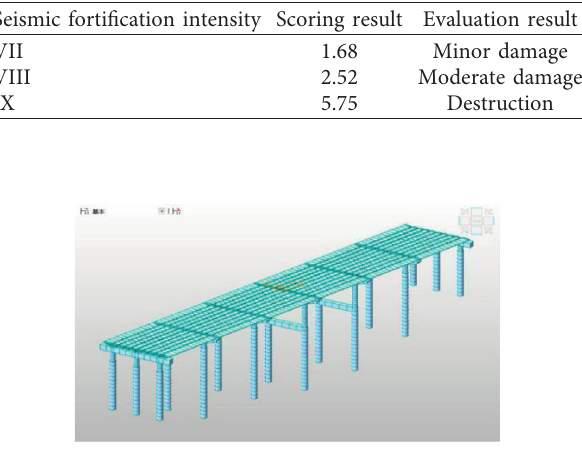
Table 10: Seismic damage prediction matrix of the bridge pier.